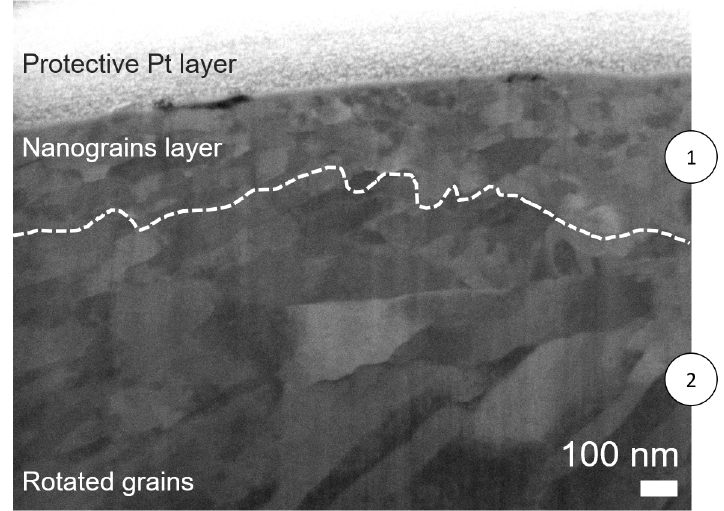
Figure 8. Nanograins layer observed on the subsurface of the specimen with initial contents of 40% martensite and processed through